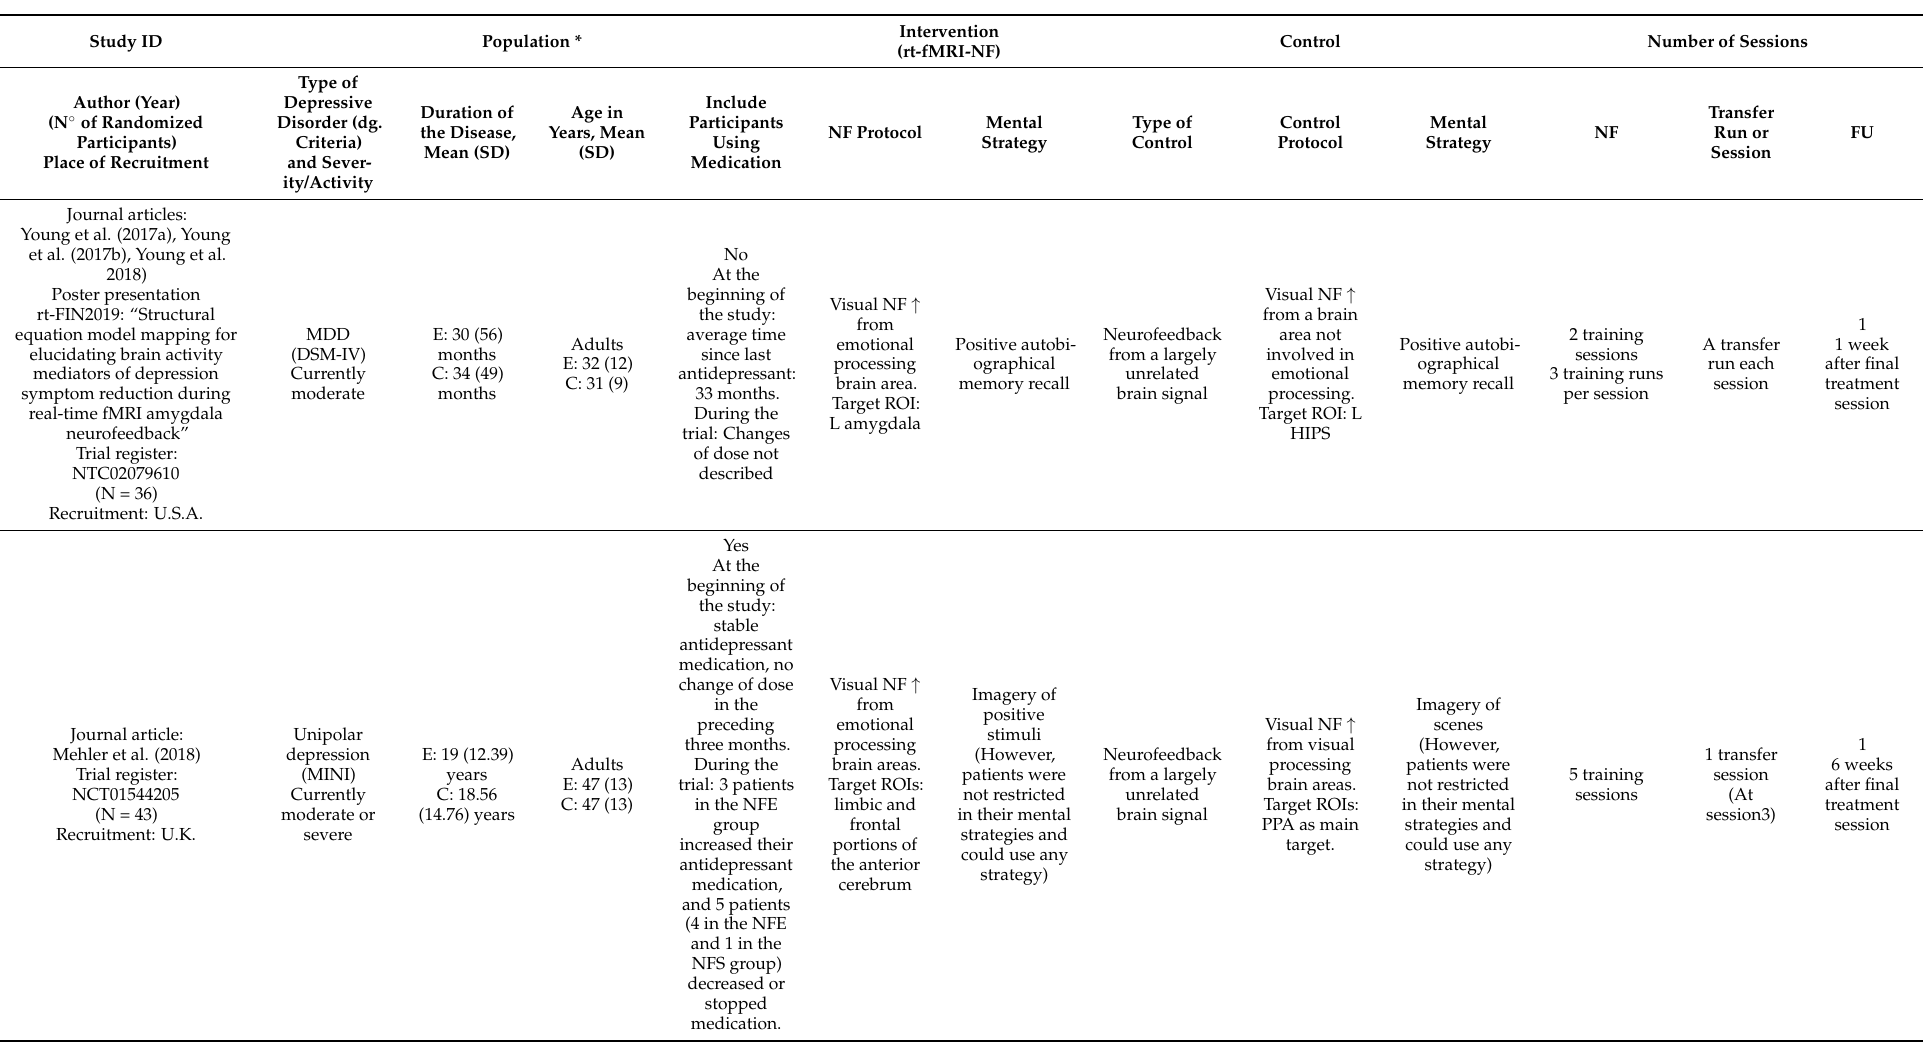
Table 1. Characteristics of